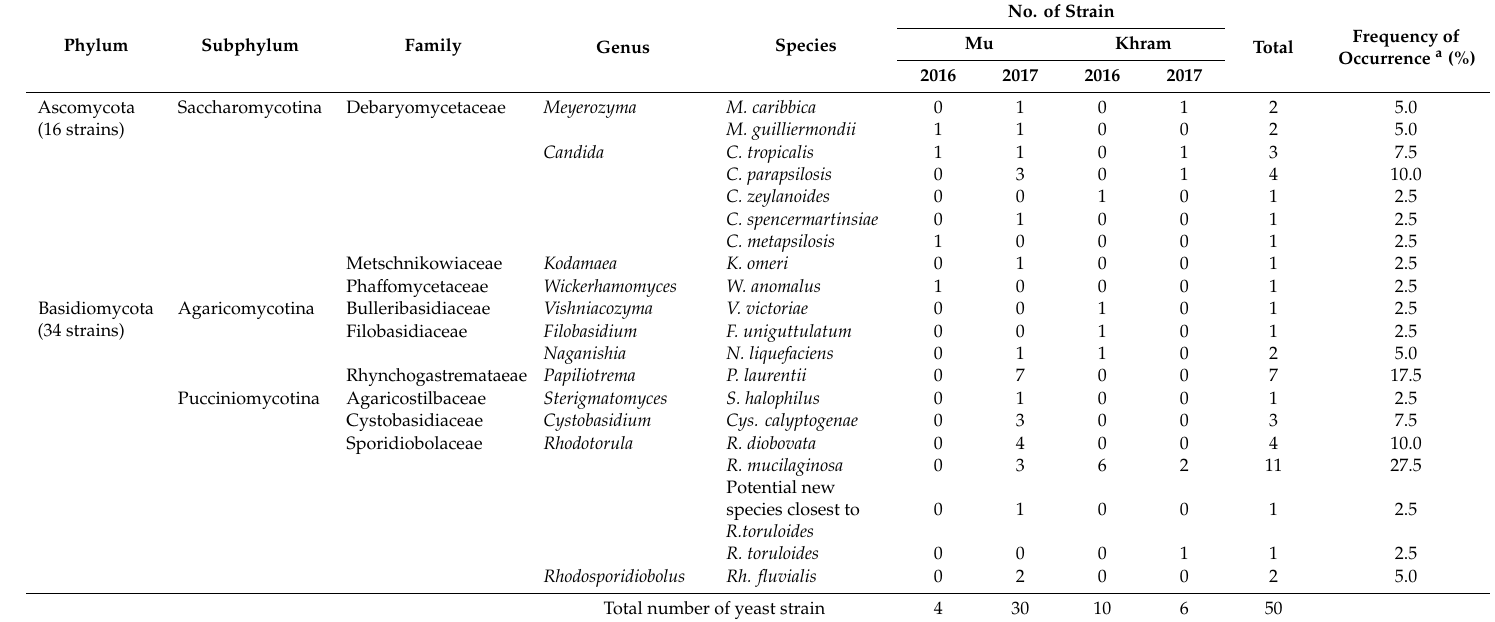
Table 2. Taxonomic summary of yeast species isolated from 40 coral and zoanthid samples, and their frequency of occurrence.